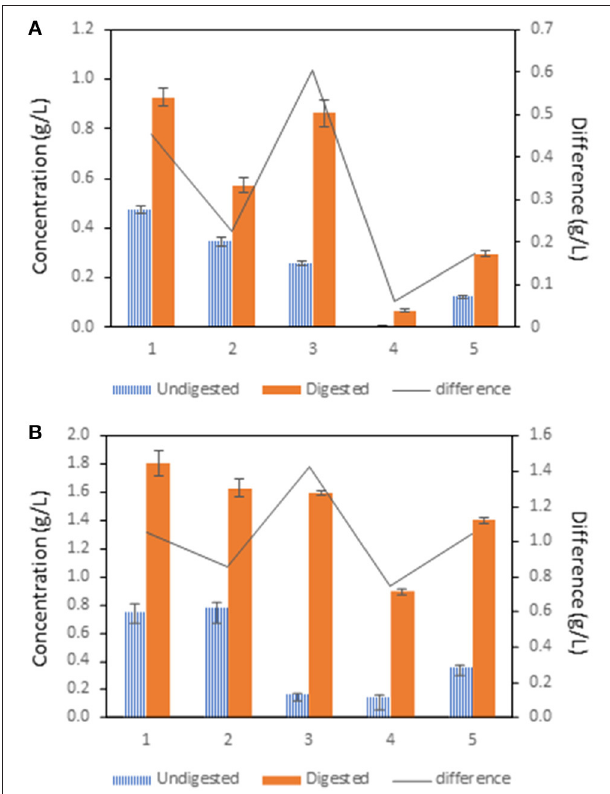
FIGURE 2 | The influence of treatment of pea flour [(1): untreated flour, (2): cooked at 100 ◦ C for 10min, (3): cooked at 100 ◦ C for 120min, (4): fermented flour without cooking, (5): fermented flour cooked at 100 ◦ C for 120min.] on saccharide digestion. The difference was calculated after subtraction of the concentration of the undigested sample from the digested sample. (A) glucose, (B)